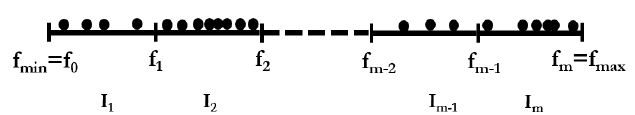
Figure 1. The illustration for the entropy diversity